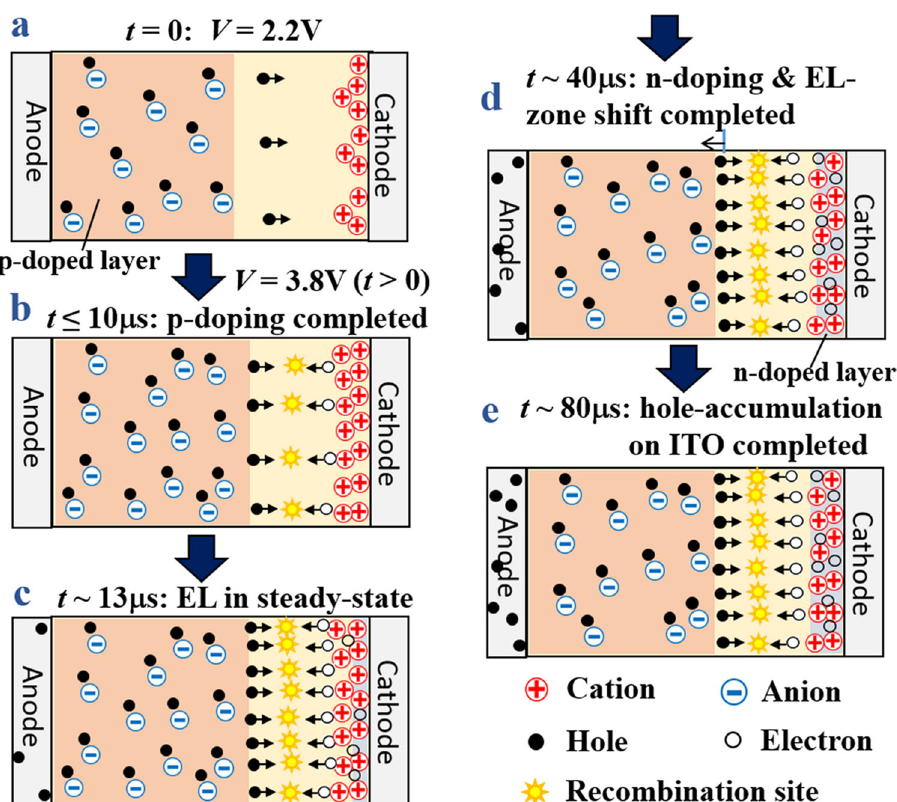
Fig. 5 | Schematic of operation dynamics of LEC. Taking the experimental situationinFig.4asanexample, a showsthestandbystateunderabiasat2.2V,and the bias is raised to 3.8V in b , which is then followed by c – e with the passage of